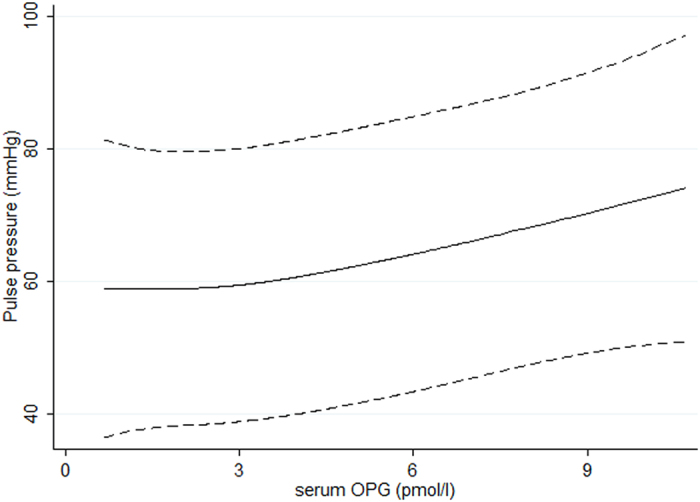
Non-linear association between OPG versus PP using restricted cubic spline.The model was adjusted according to model E in Table 3.